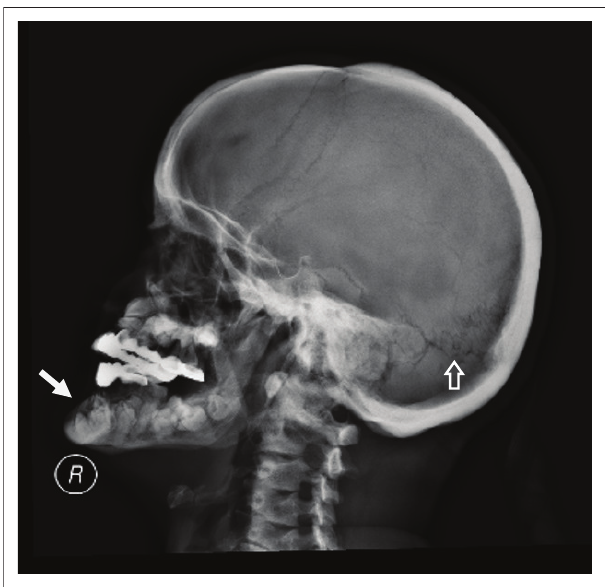
FIGURE 1: Lateral radiograph of the skull shows normal bone density with wormian bones in the lambdoid suture (hollow arrow), prognathism and supernumerary teeth (white arrow). Patient is wearing dental